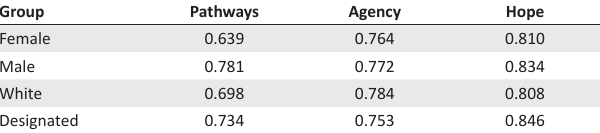
TABLE 2: Reliability estimates of the hope dimensions.